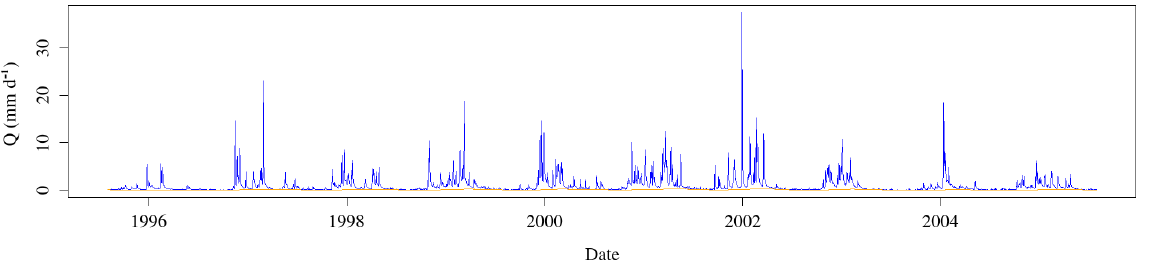
Figure 5. Hydrograph separation of the Vair River in Soulosse-sous-Saint-Élophe for 1995–2005.